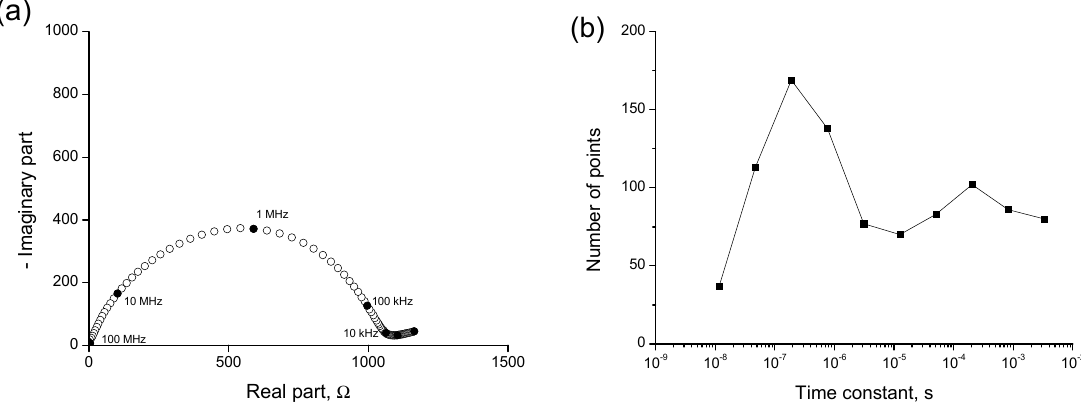
Figure 4. ( a ) Nyquist plot noted for a VP10 specimen at 200 days using the contacting method; ( b ) differential impedance analysis of the impedance spectrum represented in 0a.